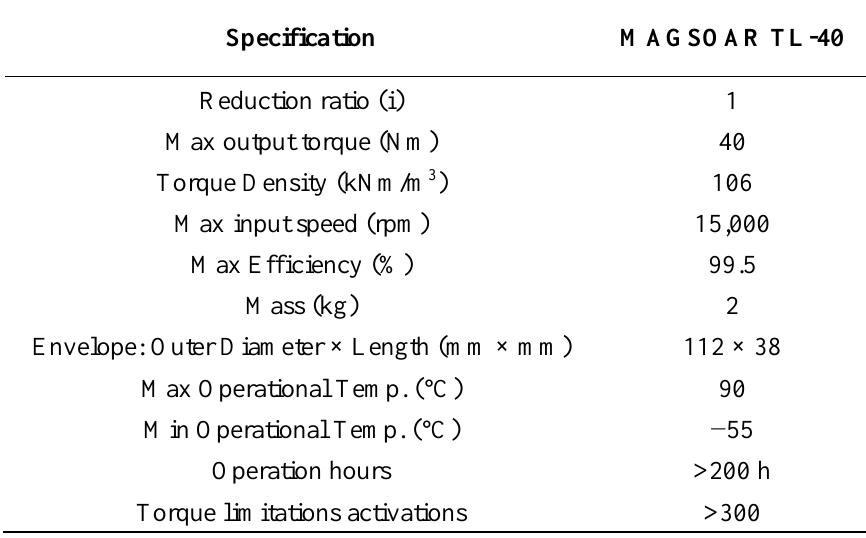
Table 3. Magnetic torque limiter TL-45 manufactured by MAG SOAR SL